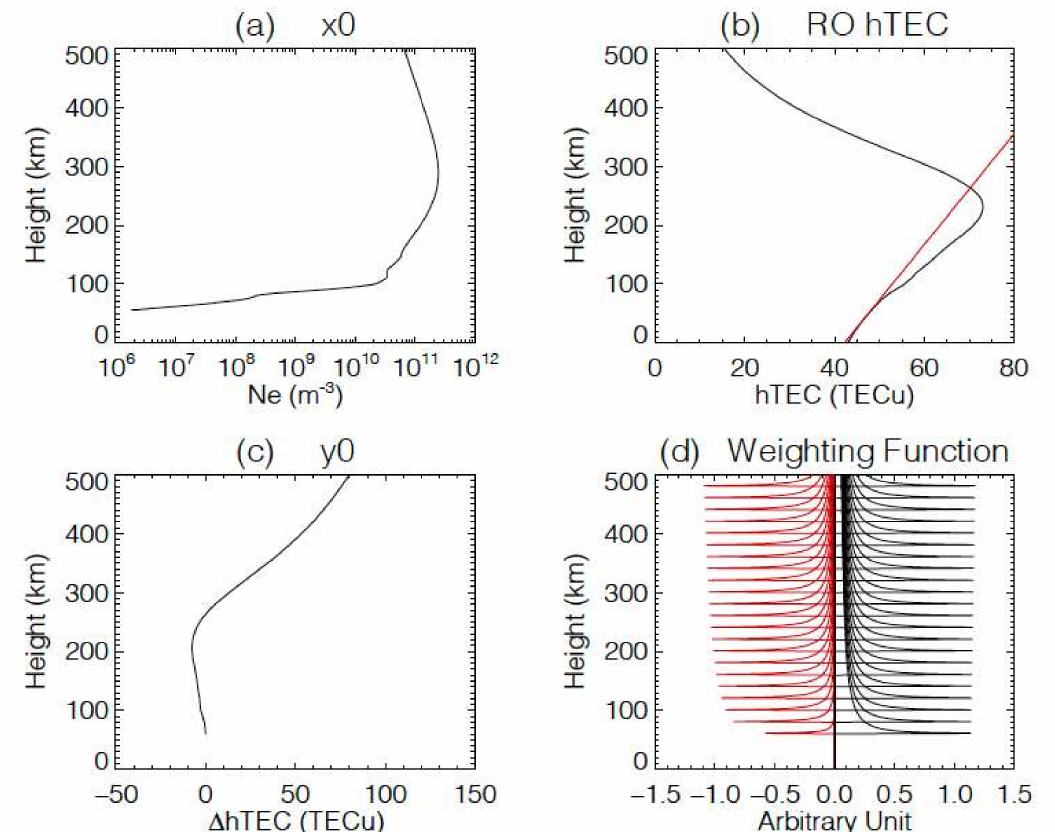
Figure 3. ( a ) State vector x 0 , ( b ) measurement vector ( ∆ hTEC = hTEC − hTEC fit ), ( c ) y linearization model, and ( d ) the associated weighting functions K (red) and their comparison with the Abel functions (black) for selected tangent heights between 50 and 500 km. The weighting functions K are flipped in sign purposely, to help the comparison. The intermediate step for the calculated RO hTEC and its linear fit (red line) from h t = 30–60 km is illustrated in ( b ), from which y their difference. See text for more